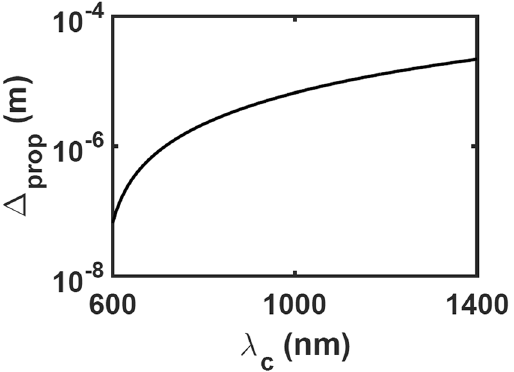
Figure 2. Variation of the propagation distance Δ prop of the carrier SPP wave with the free-space wavelength λ c when the partnering materials are silicon and